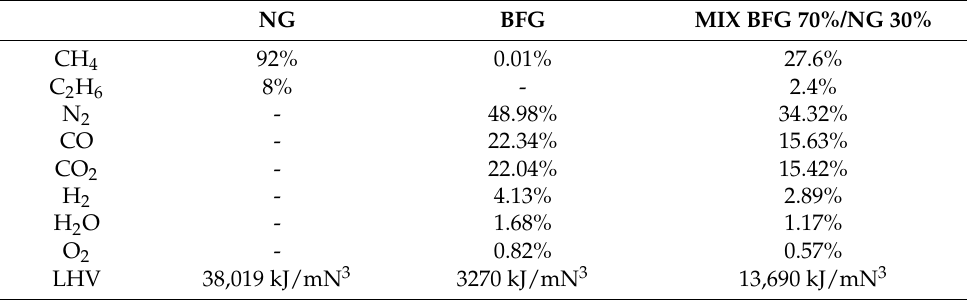
Table 1. Composition of the gaseous blends used in this study.